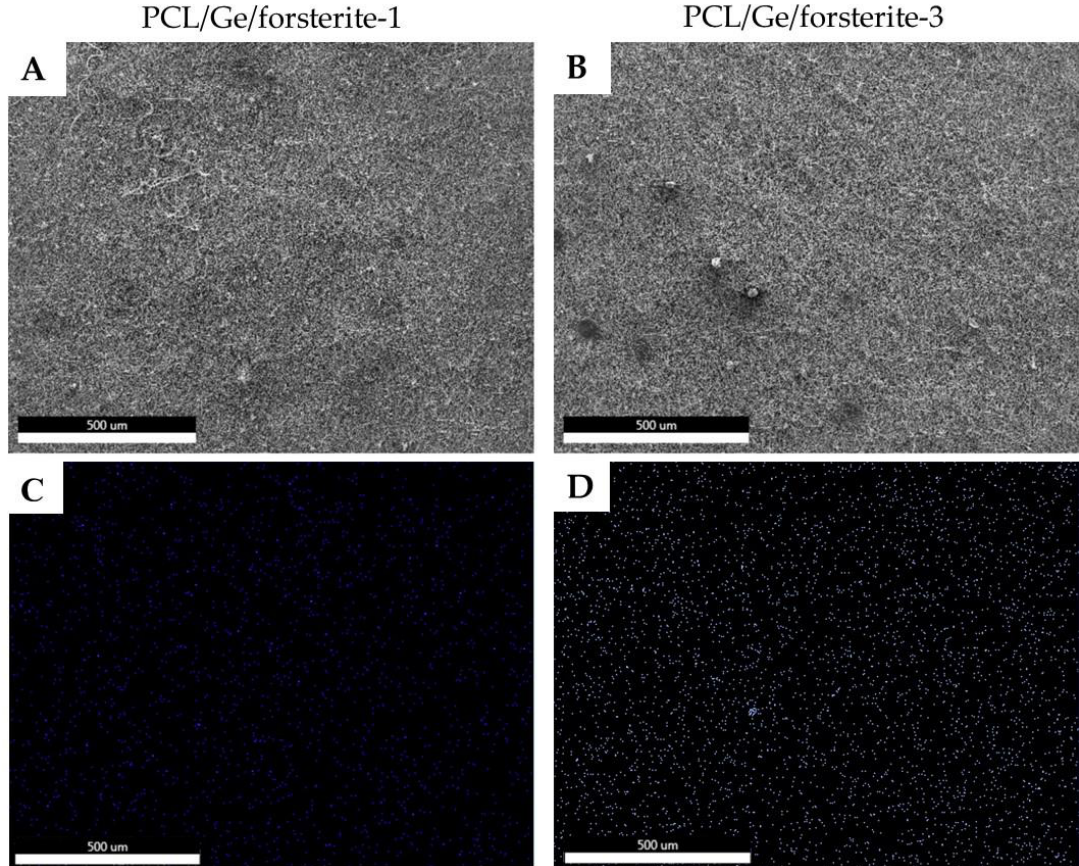
Figure 2. FESEM micrographs ( A ) and ( B ), and the distribution map of Mg element ( C ) and ( D ) of the electrospun PCL/Ge nanofibers with 1% and 3% forsterite nanoparticles.